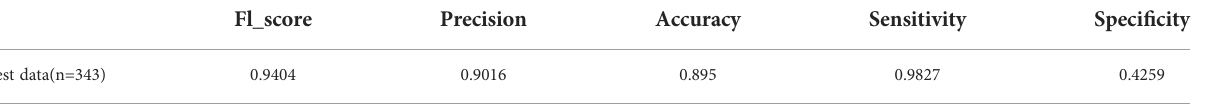
Fl_score: Harmonic mean of Precision and Sensitivity Precision: The ratio of the number of correctly classi fi ed positive samples to the total number of positive samples divided by the classi fi er. Accuracy: The proportion of correctly classi fi ed samples to all samples. Sensitivity: The ratio of the number of correctly classi fi ed positive samples to the number of positive samples. Speci fi city: The ratio of the number of correctly classi fi ed negative samples to the number of negative samples.